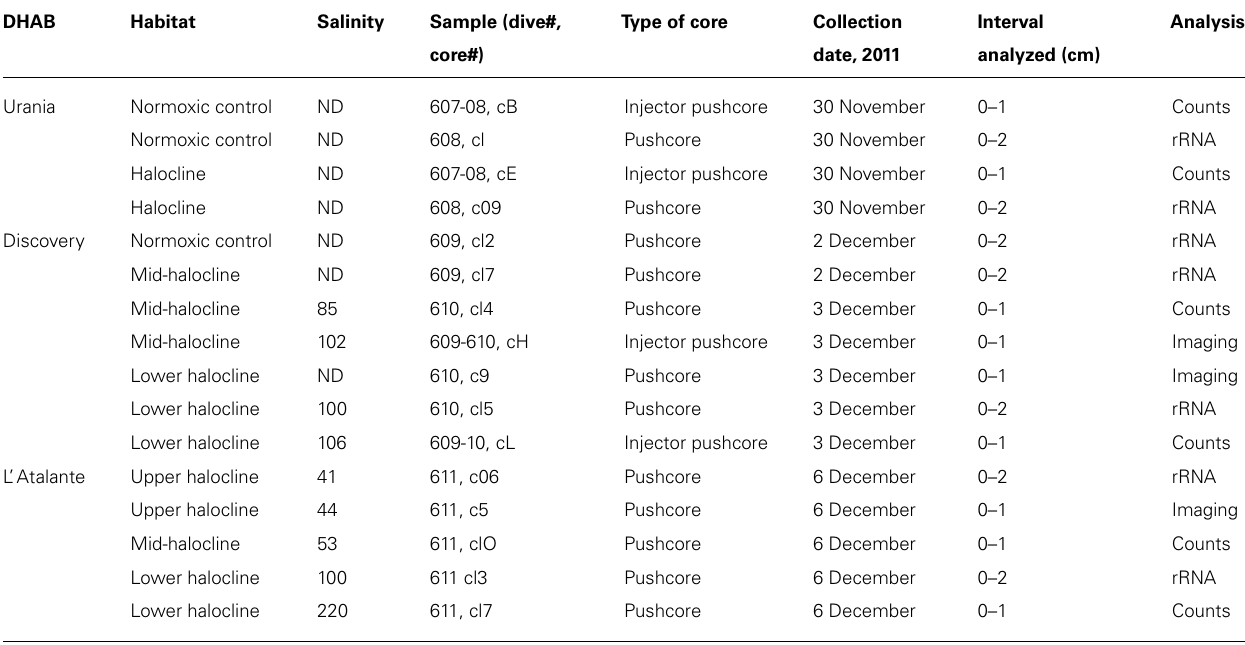
Table 2 | Samples from cruiseAT18-14 analyzed for counts, imaging (DAPI and/or CTG imaging), and rRNA sequencing. DHAB Habitat Salinity Sample (dive#,